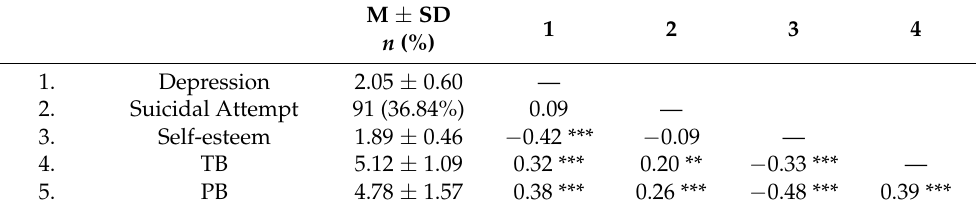
Table 3. Descriptive statistics and bivariate correlations of the study